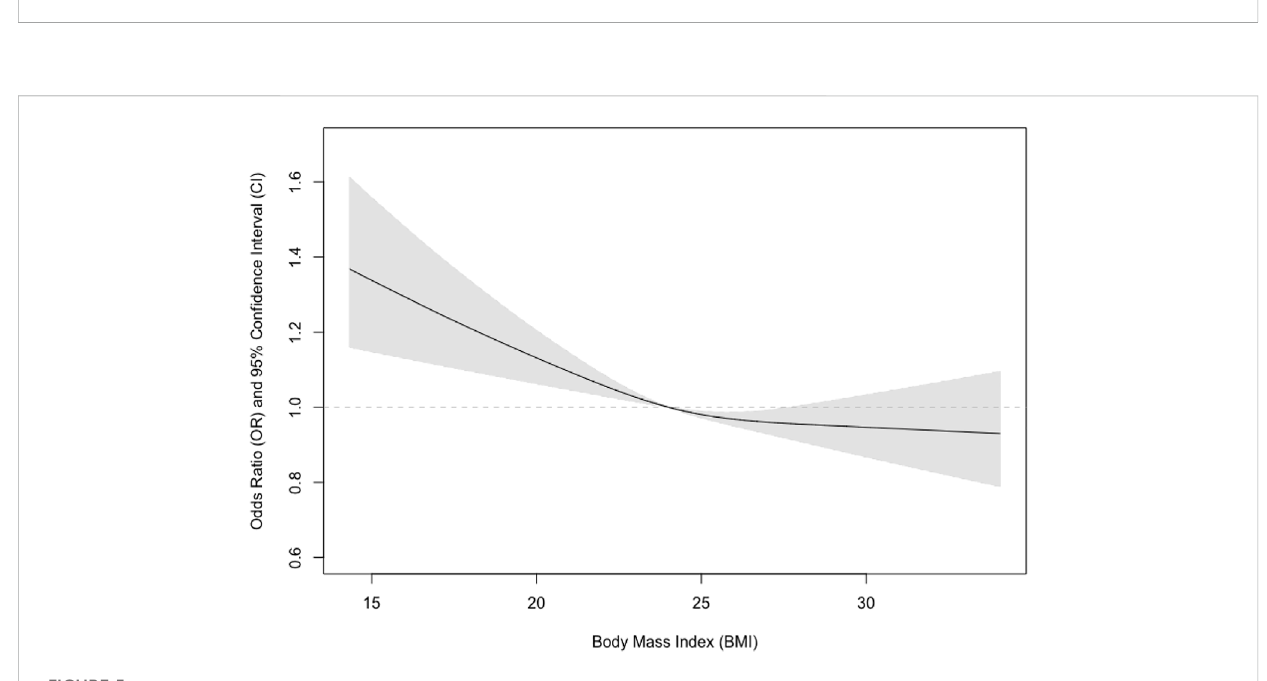
FIGURE 5 Association between body mass index and COPD in